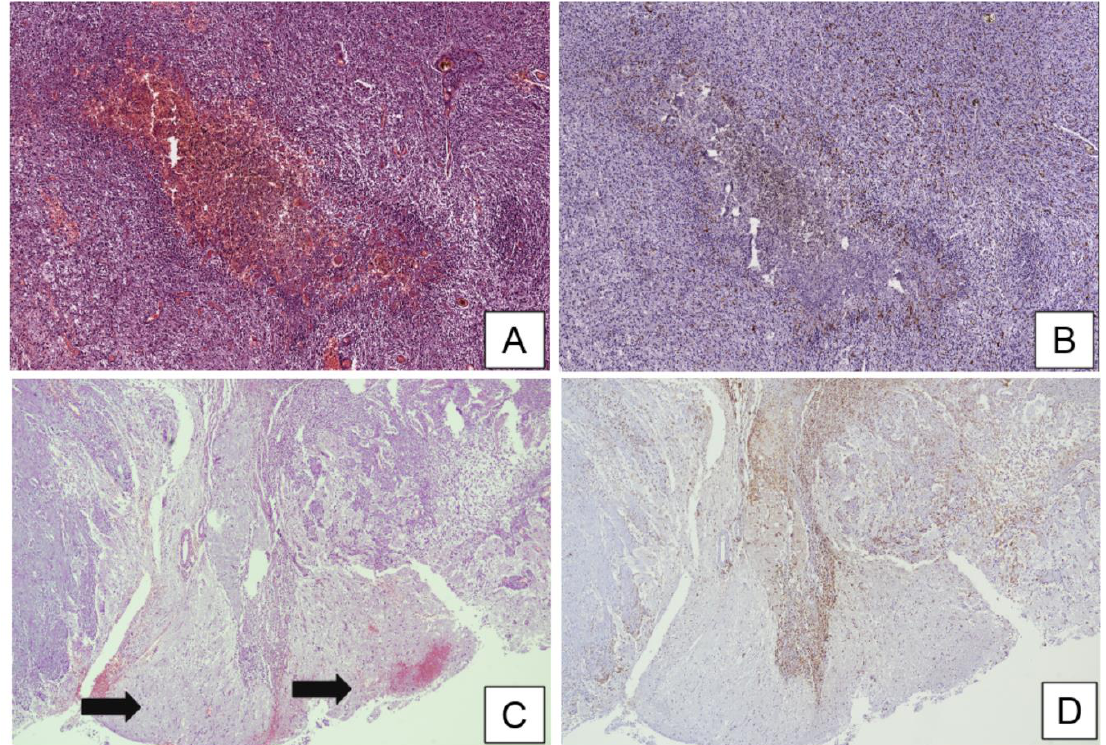
Figure 1. ( A ) Histological examination of glioblastoma (GBM) tissue sample showing a central focus of pseudopalisading necrosis, enriched with hemosiderin deposits (hematoxilin and eosin; original magnification 100×). ( B ) Immunohistochemical tests showing an abundant microglial activation, consisting of numerous clusters of differentiation (CD)163-positive glioma-associated microglia and macrophages (GAMs) that crowd the hypercellular zone surrounding the pseudopalisading necrosis (immunoperoxidase staining; original magnification 100×). ( C ) Histological detail showing fragments of unaffected brain parenchyma (arrows) at the periphery of a “classic - type” GBM, diffusely infiltrated by glioma cells (hematoxilin and eosin; original magnification 100×). ( D ) Immunohistochemical staining with CD163 highlights the presence of marked microglial activation with the M2-like phenotype at the invasive front of the tumor (immunoperoxidase staining; original magnification 100×).